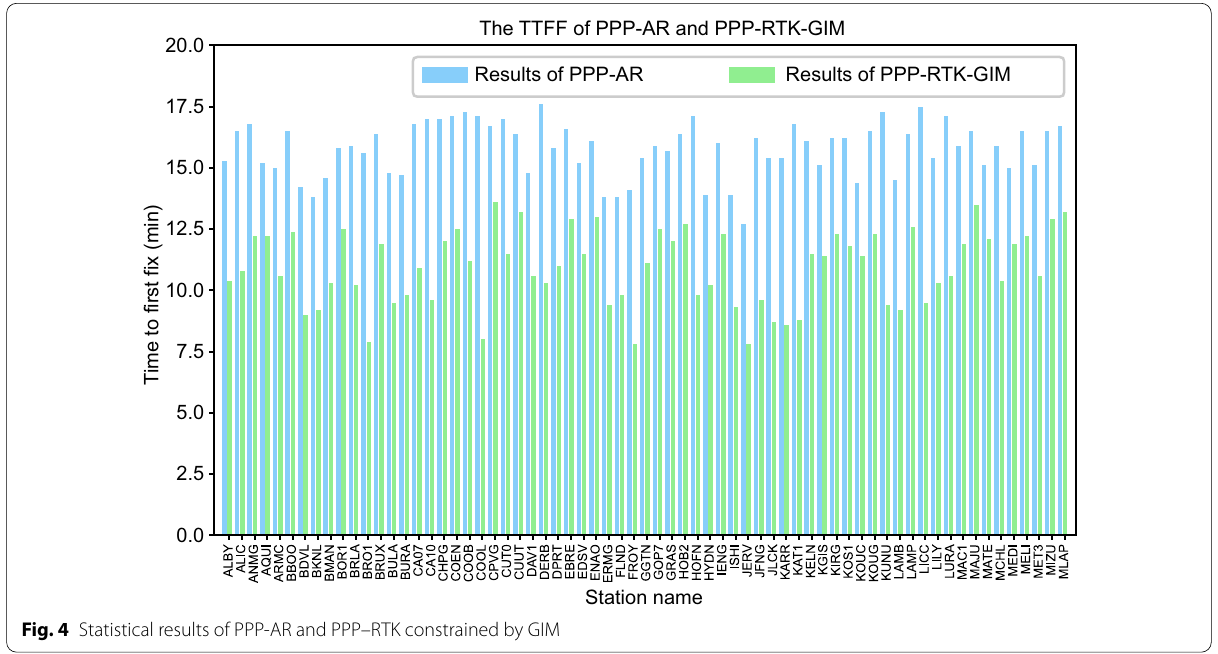
Fig. 4 Statistical results of PPP-AR and PPP–RTK constrained by